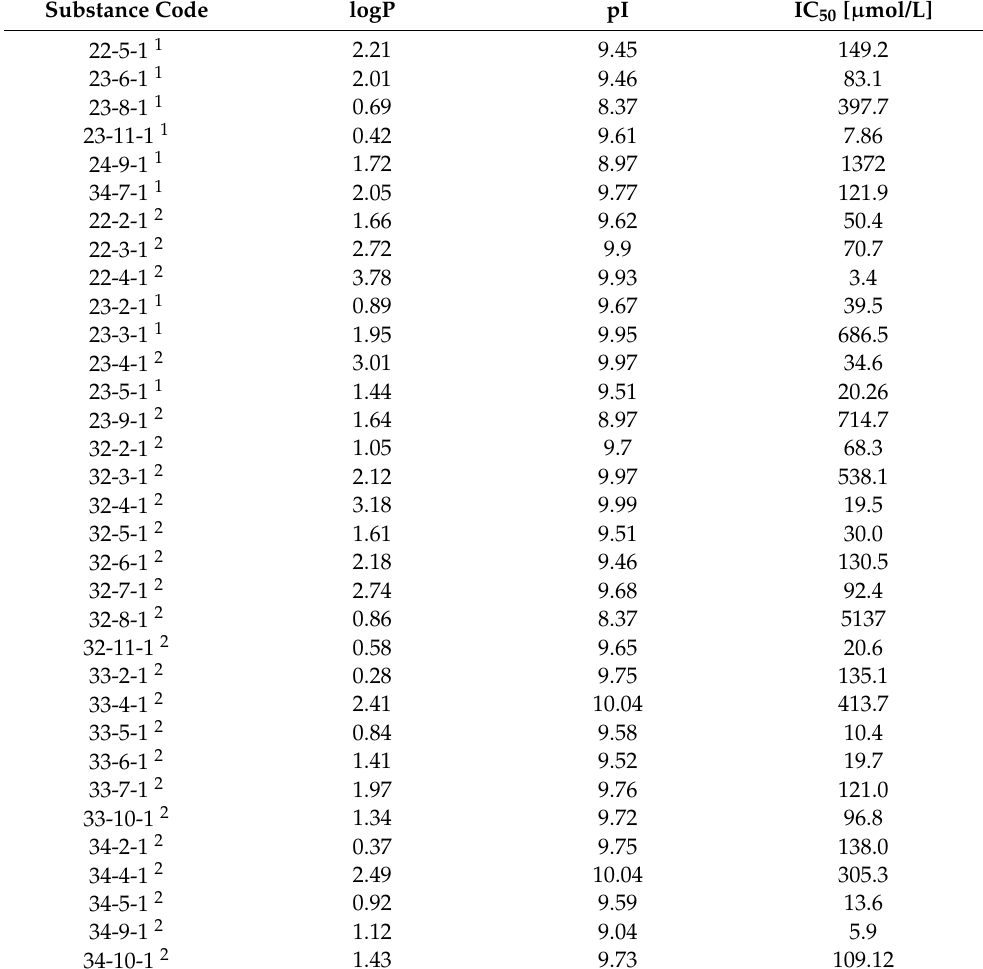
Table 3. Calculated inhibitory activity of semicarbazides and thiosemicarbazides of basically substi- tuted acetamidoacetophenones expressed as IC 50 in µ mol/L together with the calculated values of log P and pI used for IC 50